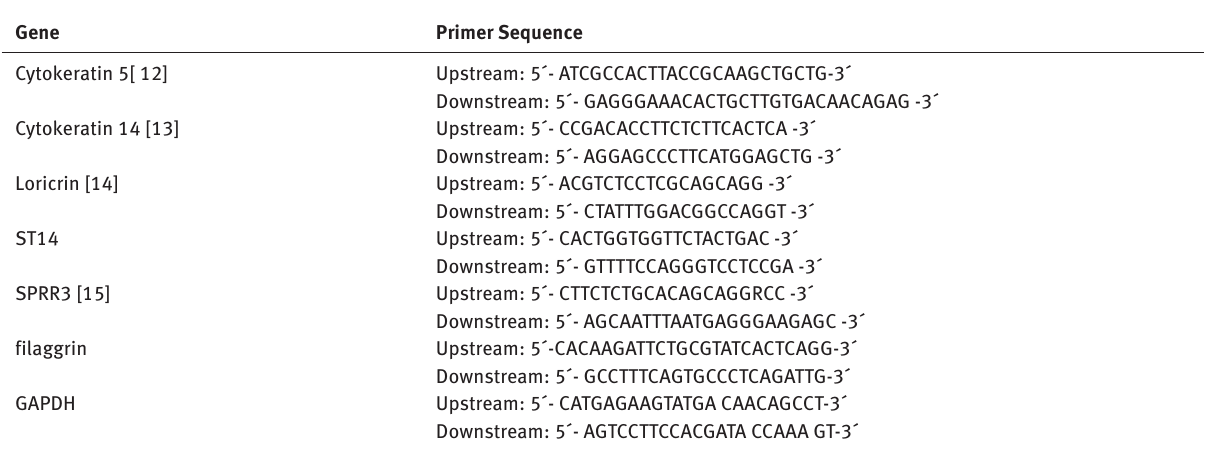
Table 1: Primer Sequences used in RT-PCR